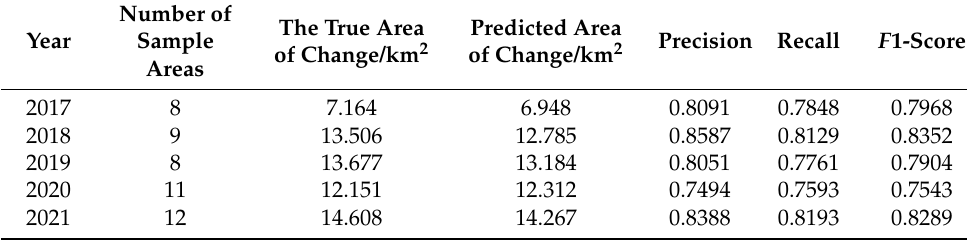
Table 4. Evaluation of all sample areas change detection accuracy metrics for